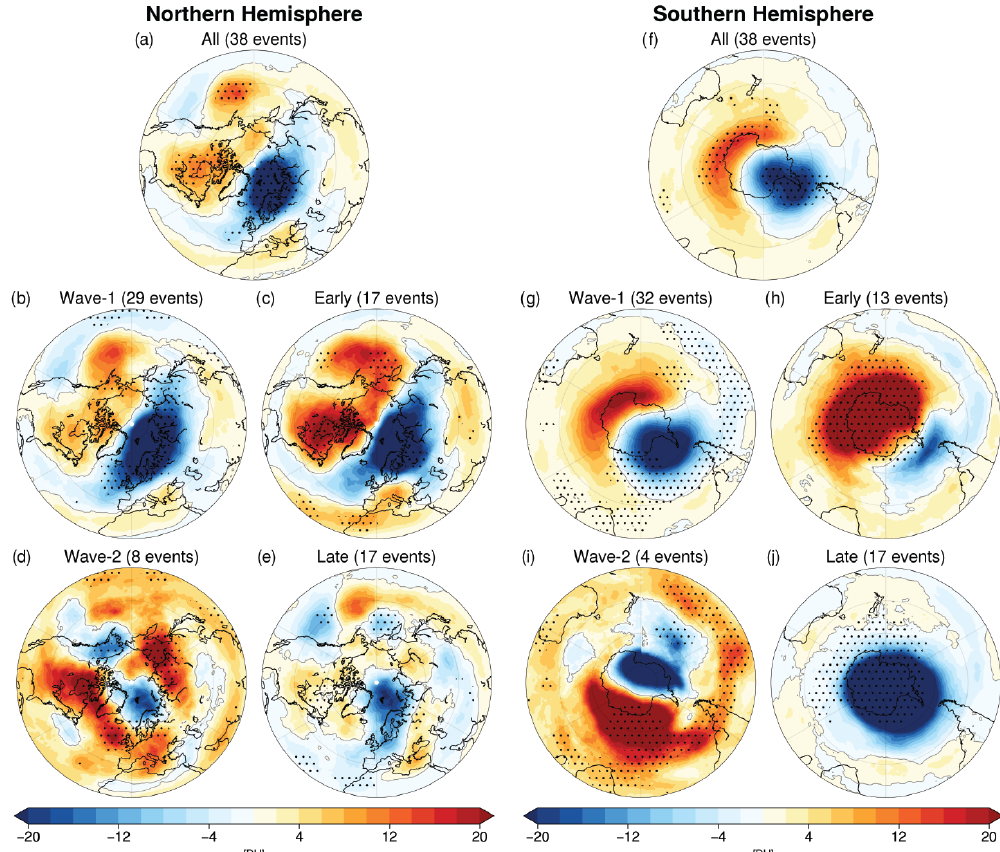
Figure 7. Composite total column ozone anomaly (Dobson units) averaged over the 10d prior to FSWs at 10hPa for (a–e) the NH and (f–j) the SH. Panels show the composites based on (a, f) all events from 1979–2016 (the period of the TCO dataset), (b, g) wave-1 or (d, i) wave-2 classification, or (c, h) early or (e, j) late classification. Stippling in (a, f) indicates regions where the anomaly composites are significantly different from zero at the 95% confidence level according to a two-tailed t test; stippling in other panels shows where composites are significantly different from each other (e.g., wave-1 vs. wave-2, early vs. late) using a t test for two samples of unequal